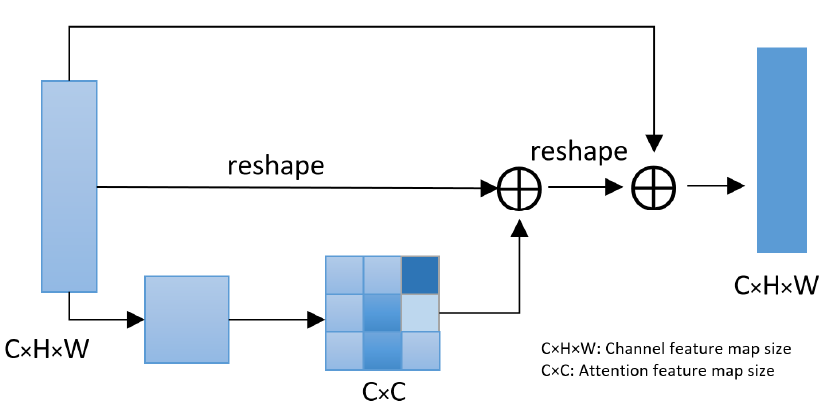
Figure 5. Channel attention